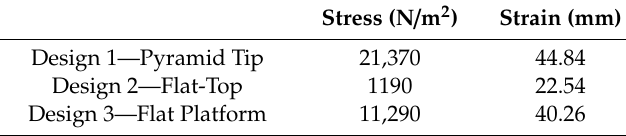
Table 1. Simulation results of localized stress and maximum strain for the three kirigami